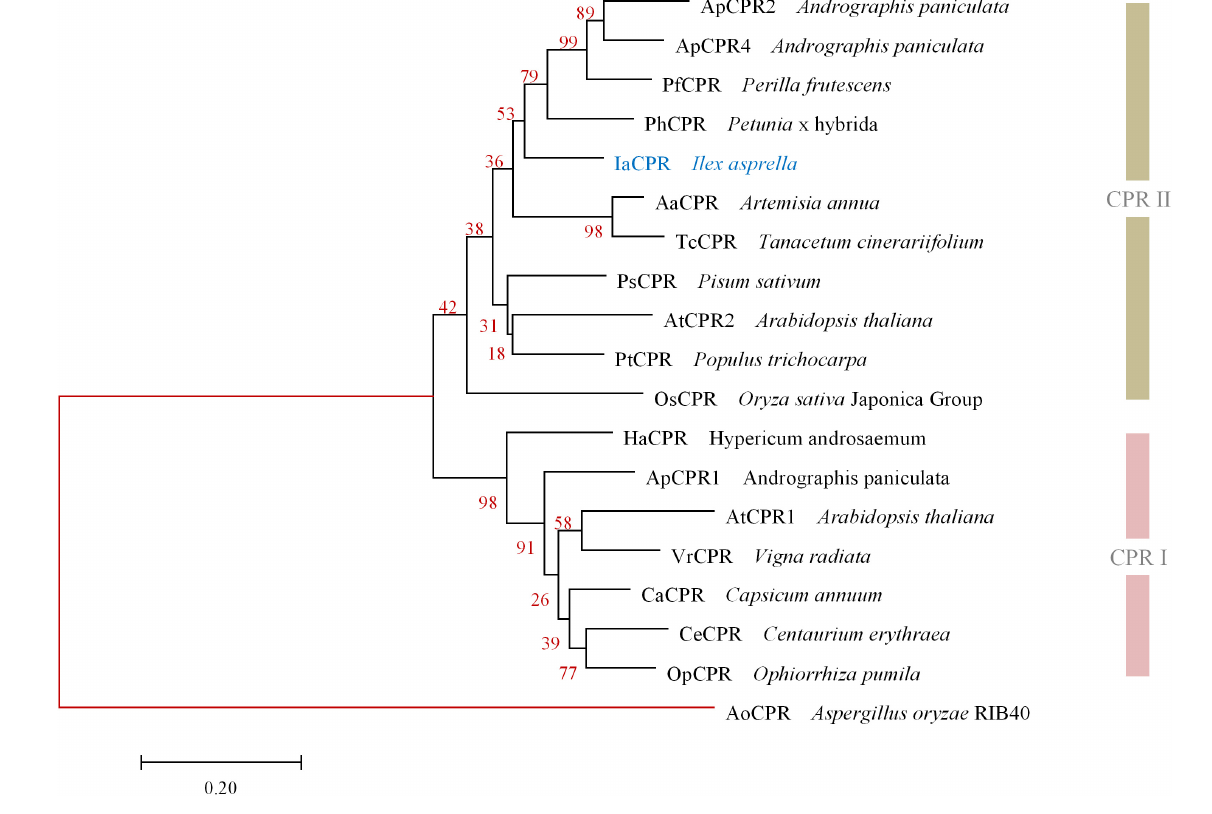
Frontiers in Plant Science |